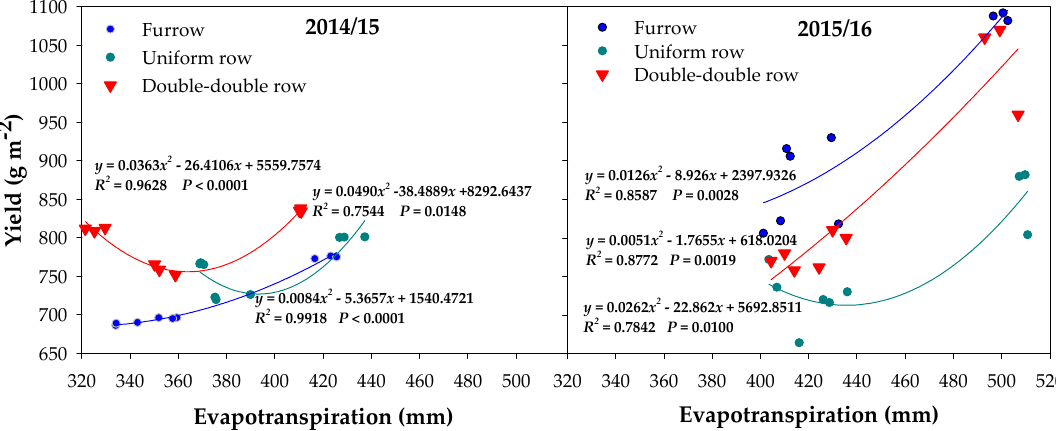
Figure 7. Relationship between yield and evapotranspiration for different planting modes in 2014–2016. The values are the average of replications for each treatment.